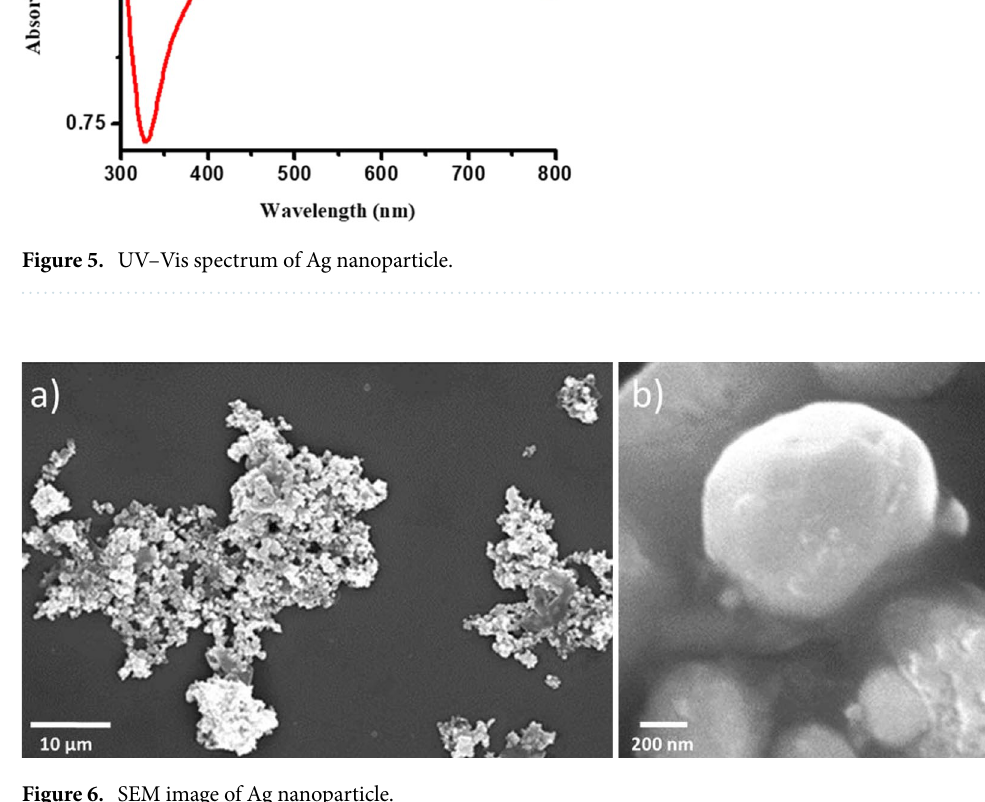
Figure 6. SEM image of Ag